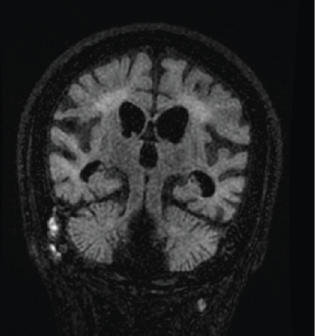
Figure 2: Coronal FLAIR sequence showing periventricular in- creased FLAIR signal consistent with white matter change, ven- triculomegaly, including enlargement of the temporal horns, hippocampal, and generalized cortical and cerebellar